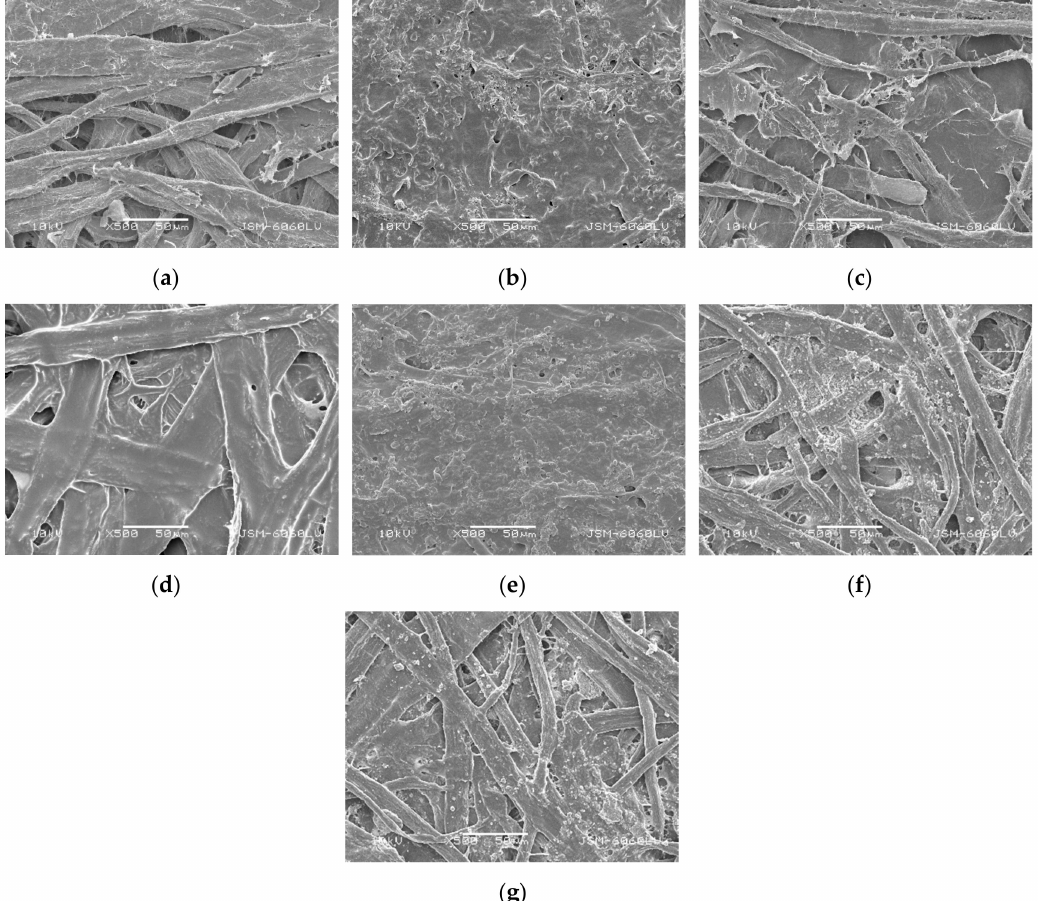
Figure 6. SEM micrographs of the uncoated ( a ), chitosan and zein coated ( b ), blend zein and rosemary oil coated ( c ), blend chitosan and rosemary oil coated ( d ), chitosan and blend zein and rosemary oil coated ( e ), pure chitosan in one layer coated ( f ) and the pure zein in one layer coated ( g ) paper, at magnification 500 ×